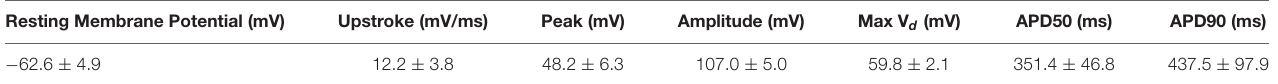
Resting Membrane Potential (mV) Upstroke (mV/ms) Peak